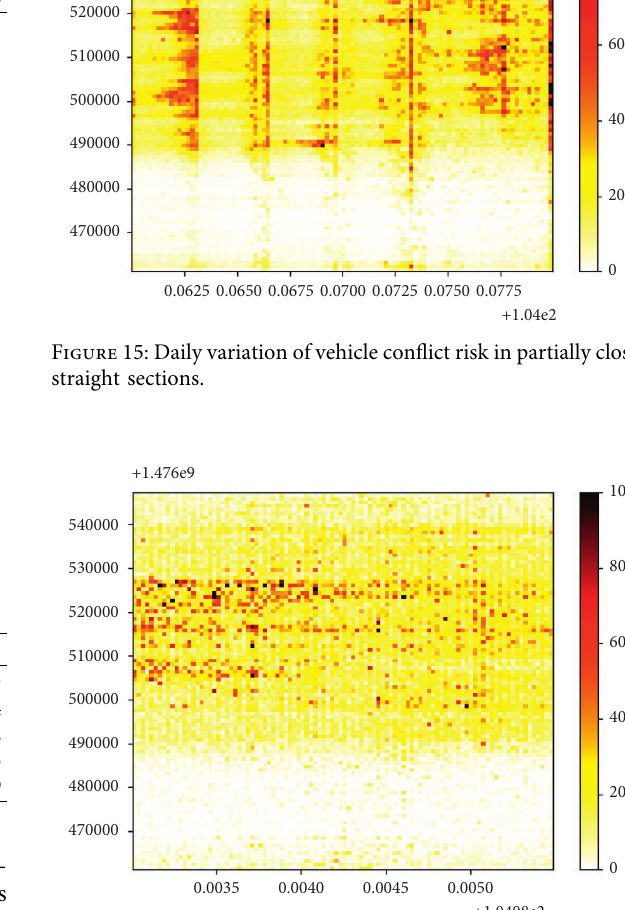
Figure 16: Daily variation of vehicle conflict risk in closed curve